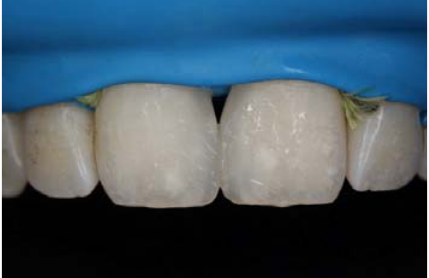
Figure 6: A1 shade composite resin was used as dentin layer and a thin layer of JE shade was used as the top enamel layer. Labial surfaces of the restorations were flattened by using a red banded knife-edge tip diamond bur.